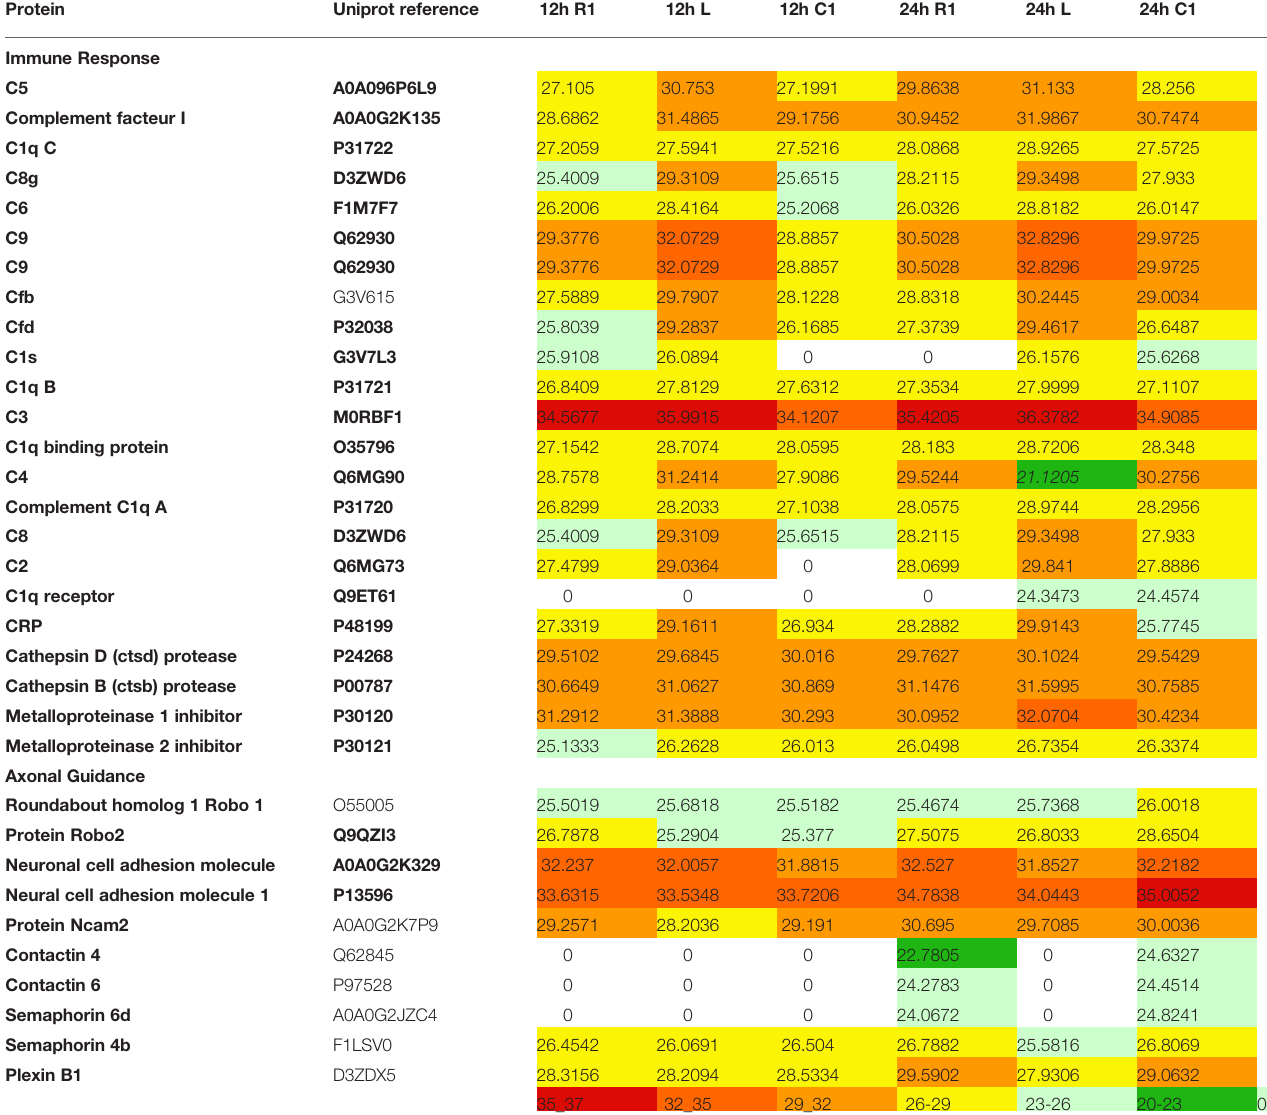
TABLE 1 | Label free quanti fi cation (LFQ) values of proteins found in 12 h and 24 h secretomes. Protein